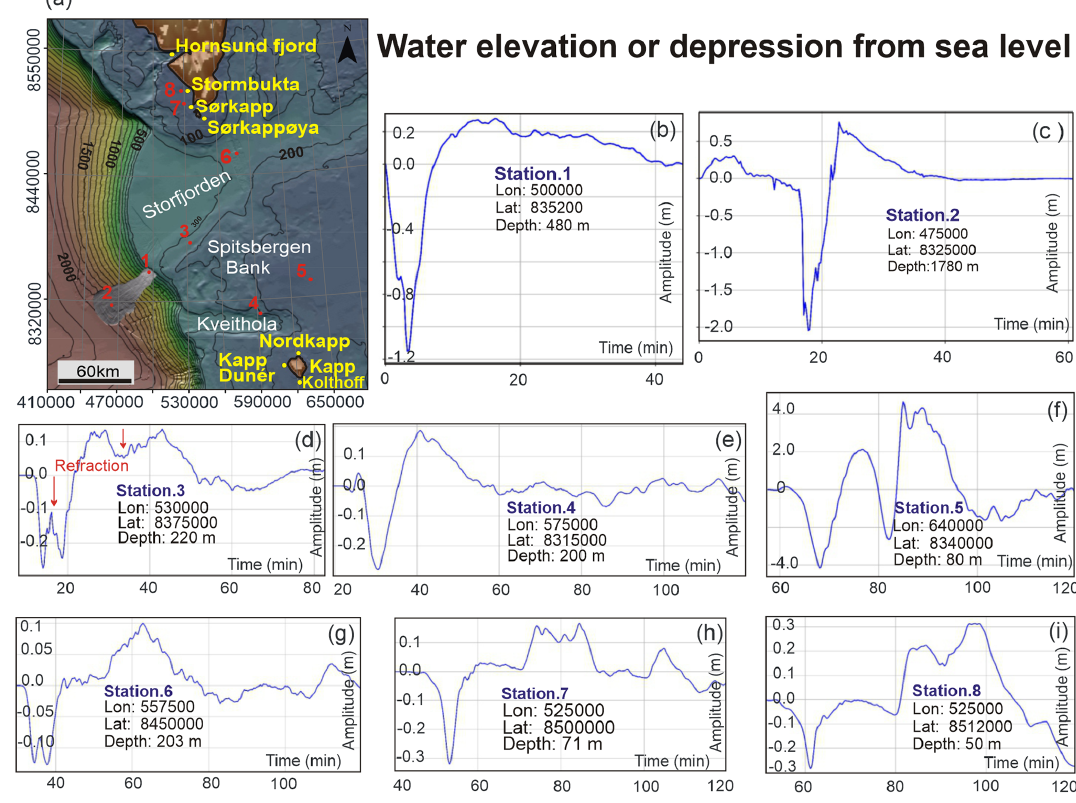
Figure 9. Synthetic marigrams. (a) The location map of the synthetic marigrams above the reference stations, numbered in panel (a) (station 1 to 8). (b–i) Note the different arrival times, periods, wave heights and polarities at the different